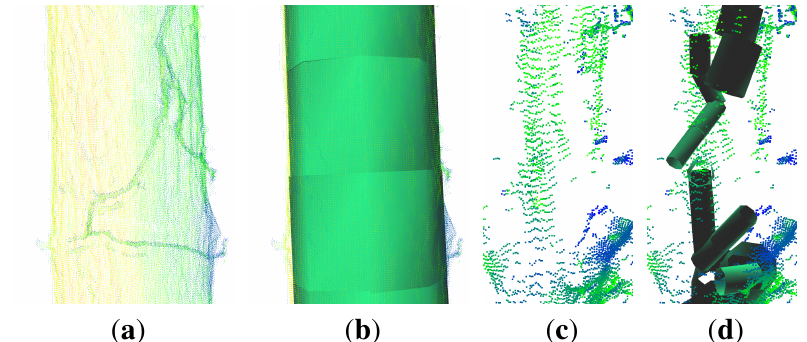
Figure 3. Close up view of a Q. petraea Q#8: (a) sub-point cloud of high quality in the mid of the stem; (b) the fitted stem in this area; (c) sub-point cloud of low quality in the crown; (d) erroneous stem cylinders with an underestimated diameter in this segment of the tree.